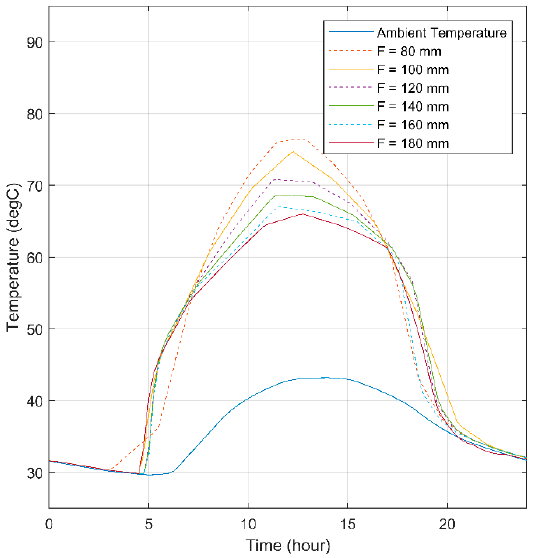
Figure 15. Midpoint temperature for triangular SHC for different values of focal length.